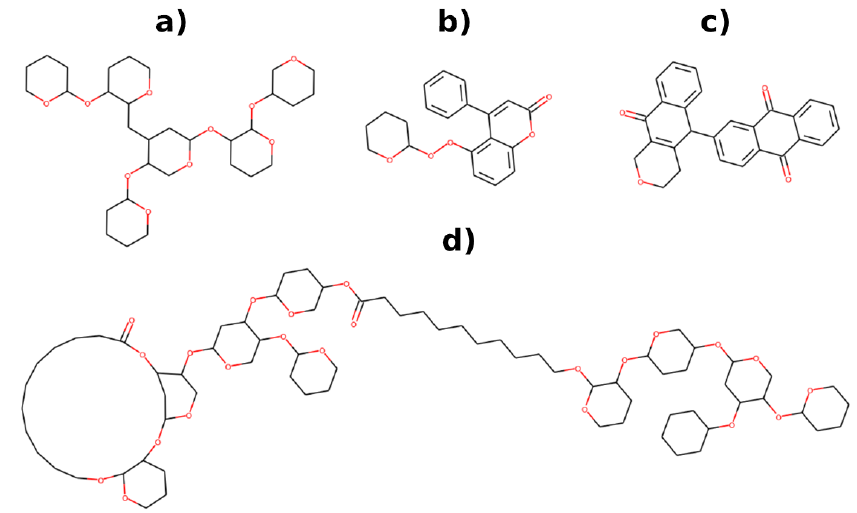
Figure 2. Representative unique scaffolds from